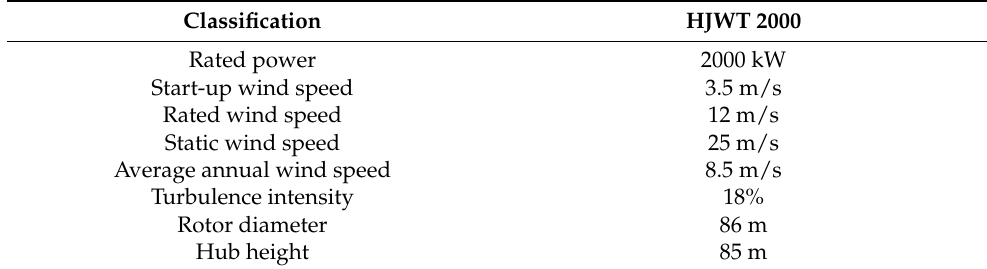
Figure 6. Designed algorithm of predictive processes. Table 3. HJWT 2000 technical specifications